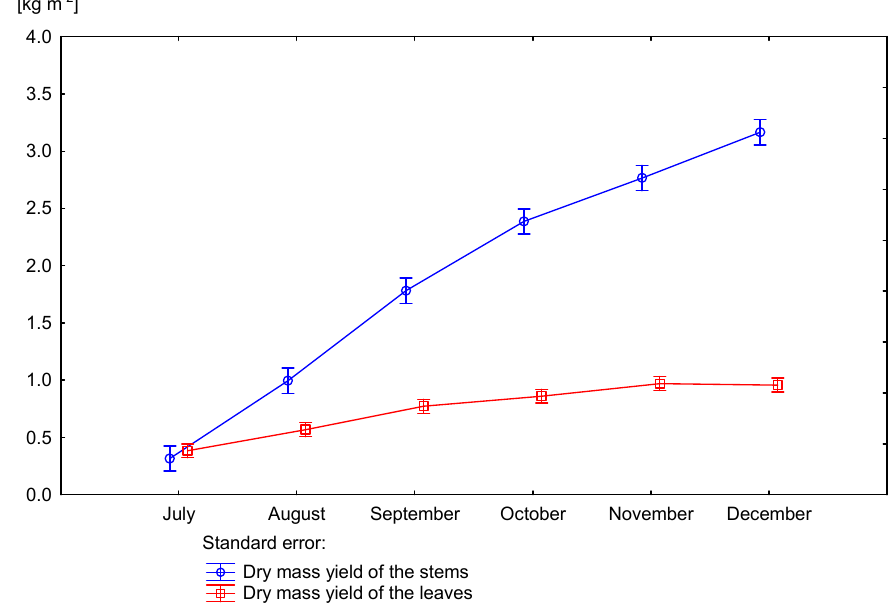
Table 6. The yield of the dry mass of Miscanthus × giganteus (kg m − 2 ) (average for years 2014–2016). Dose